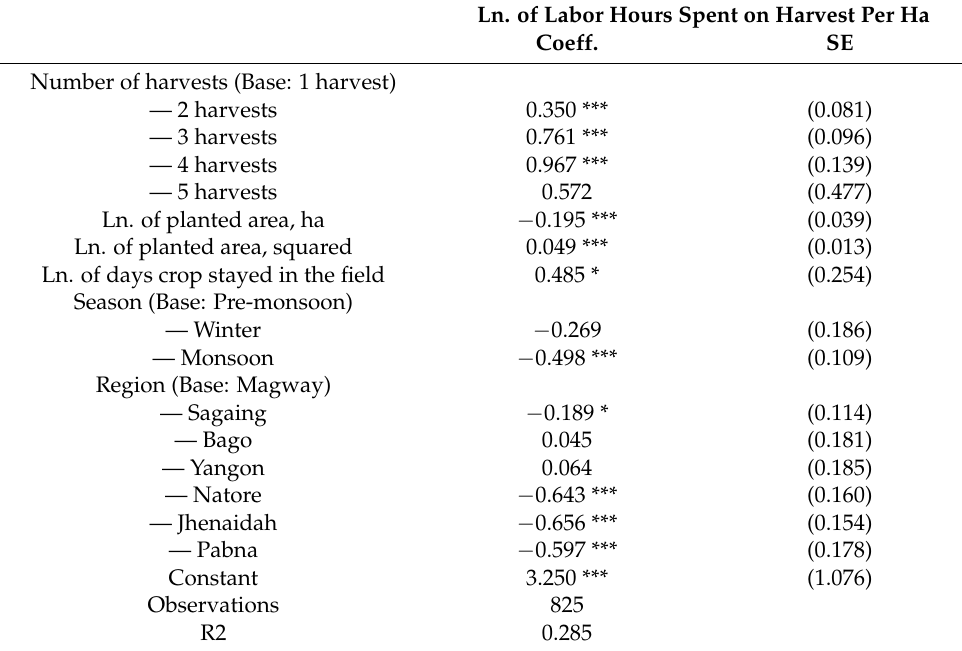
Table A1. Association between frequency of harvests and the labor requirement. Ln. of Labor Hours Spent on Harvest Per Ha Coeff. SE